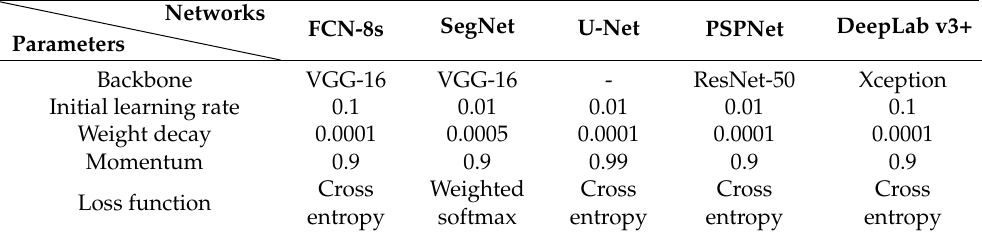
Figure 3. Training data of each semantic segmentation network base model. Table 1. Training Hyperparameters for Five Semantic Segmentation